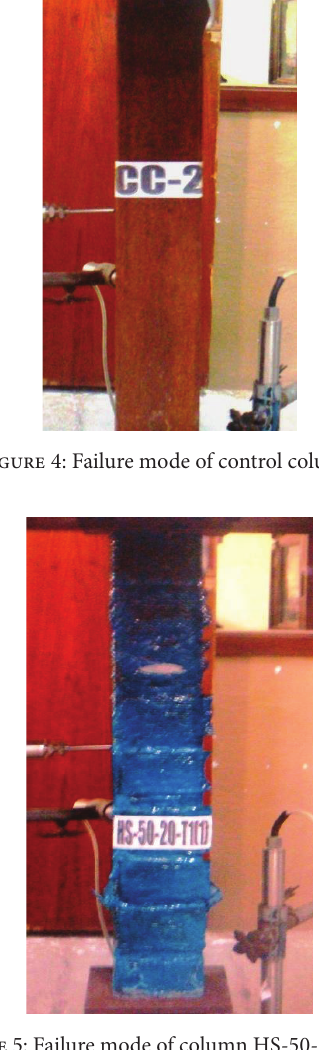
Figure 5: Failure mode of column HS-50-20-T1 (1)